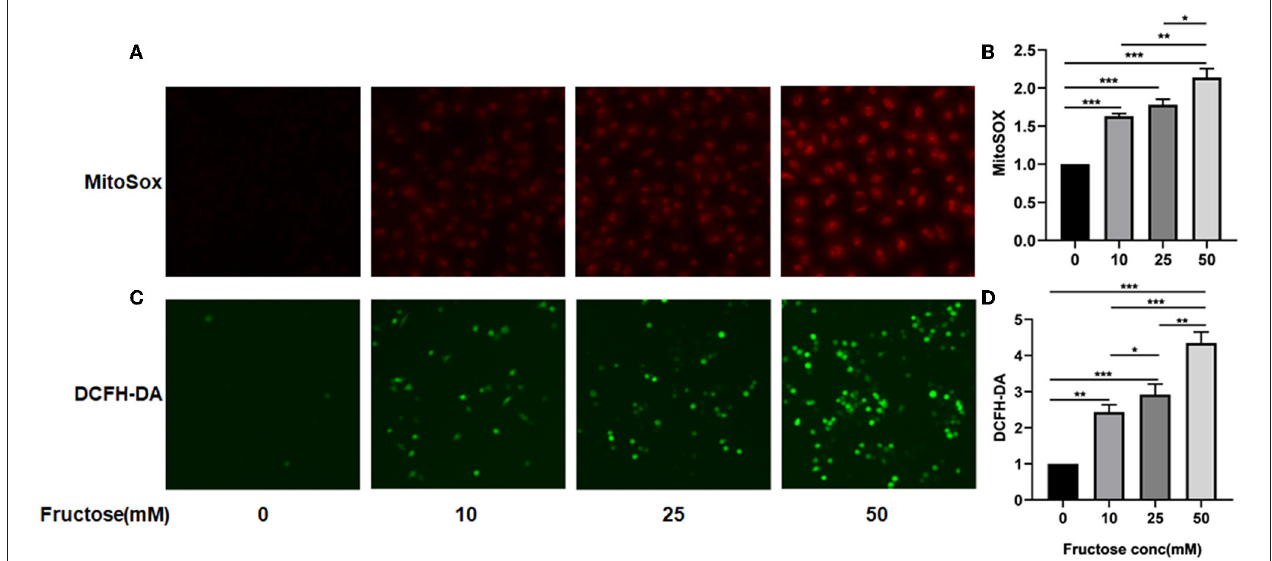
FIGURE 5 | Effects of fructose on total and mitochondria ROS levels in A549 cells. A549 cells were cultured with different concentrations of fructose (0, 10, 25, and 50 µ M) for 24h and then were stained with MitoSOX and DCFH-DA, respectively, as described in the “Materials and Methods” section. The morphology of cells was observed under a fluorescence microscope, and representative images for total and mitochondria ROS are represented in (A,C) , respectively. Additionally, the absorbance value of MitoSOX (B) and DCFH-DA (D) was obtained using the enzyme meter. The value of MitoSOX and DCFH-DA (D) is obtained by the following formula: (OD value of fructose-treated group)/ (OD value of control group). One-way ANOVA followed by Tukey’s test was used for comparison between groups. These experiments were repeated three times. * p < 0.05, ** p < 0.01, and *** p <